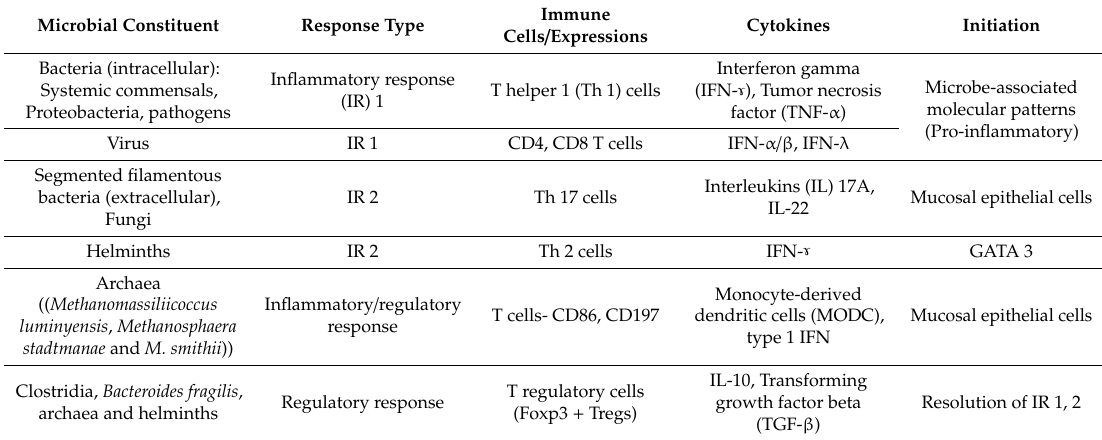
Table 8. The immune responses associated with di ff erent members of the microbiome ([1,149,150]). Microbial Constituent